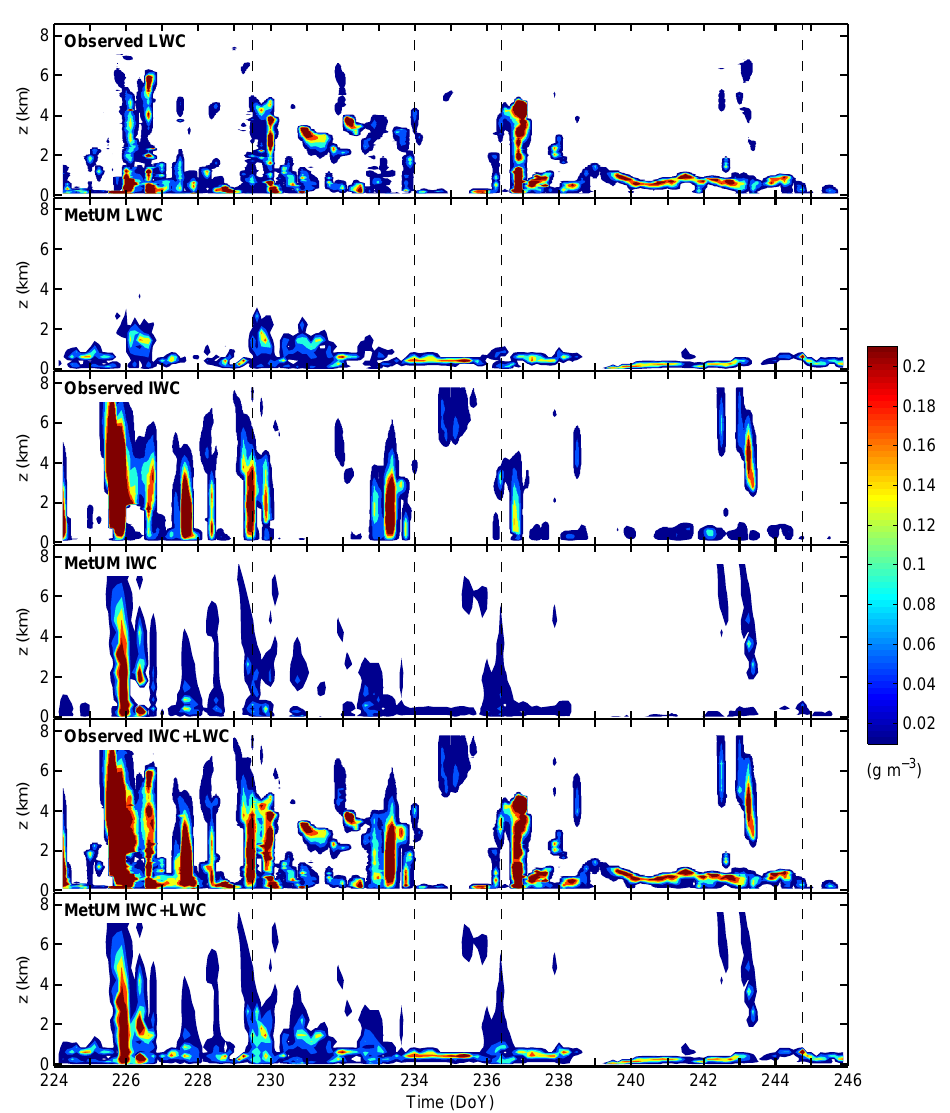
Fig. 3. 3-hourly averaged liquid, ice and total cloud water concentrations observed during ASCOS and diagnostics from the MetUM. The observations are a product derived from measurements made by the remote sensing instruments. The vertical dashed lines represent the boundaries between the five temperature